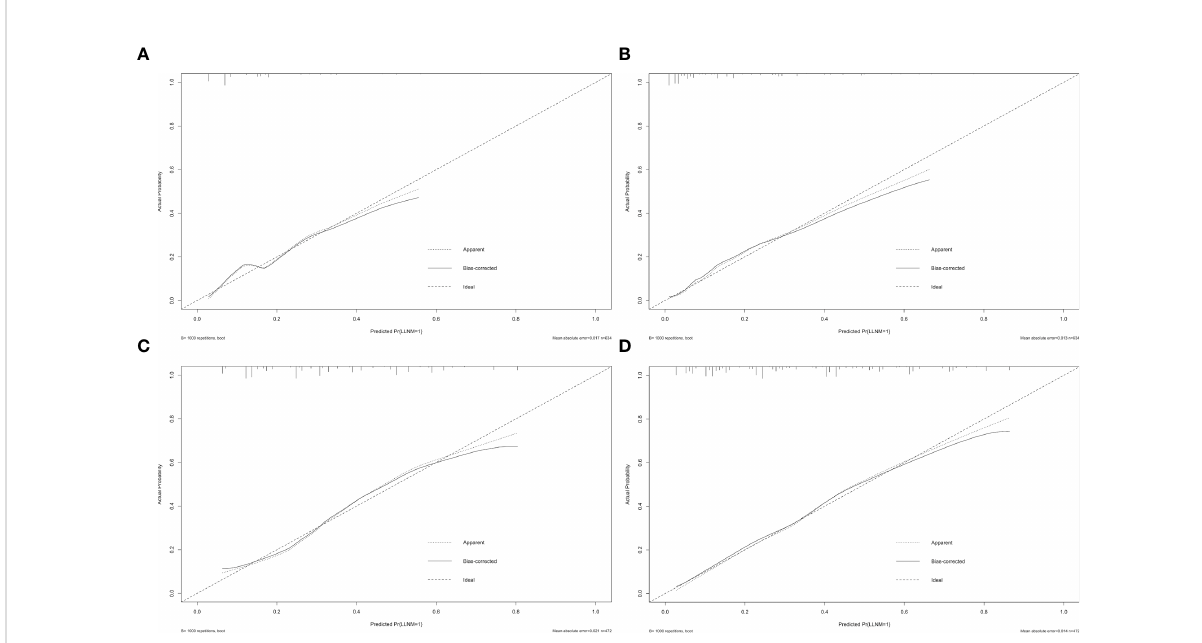
FIGURE 5 Calibration curves of nomograms for predicting LLNM. The diagonal dashed line represents the ideal prediction by the perfect nomogram; the solid line represents the calibration estimate from the internally validated model; the dotted line indicates the apparent predictive accuracy. The closer the solid line is to the dotted line, the stronger the predictive ability of the model. (A) Calibration curve for the preoperative model of predicting LLNM in PTMC patients; (B) calibration curve for the postoperative model of predicting LLNM in PTMC patients; (C) calibration curve for the preoperative model of predicting LLNM in macro-PTC patients; (D) calibration curve for the postoperative model of predicting LLNM in macro-PTC